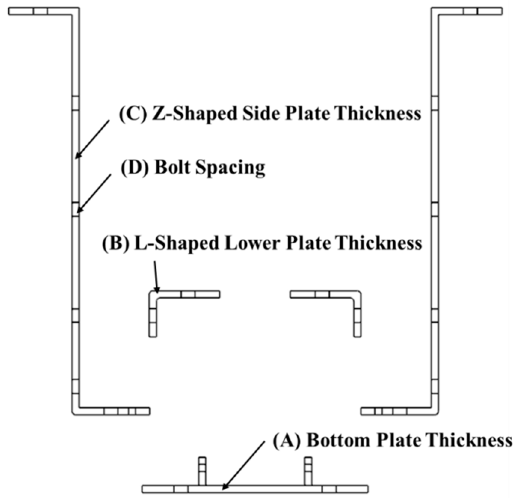
Figure 2. Analytical variables of the proposed retrofitting system.